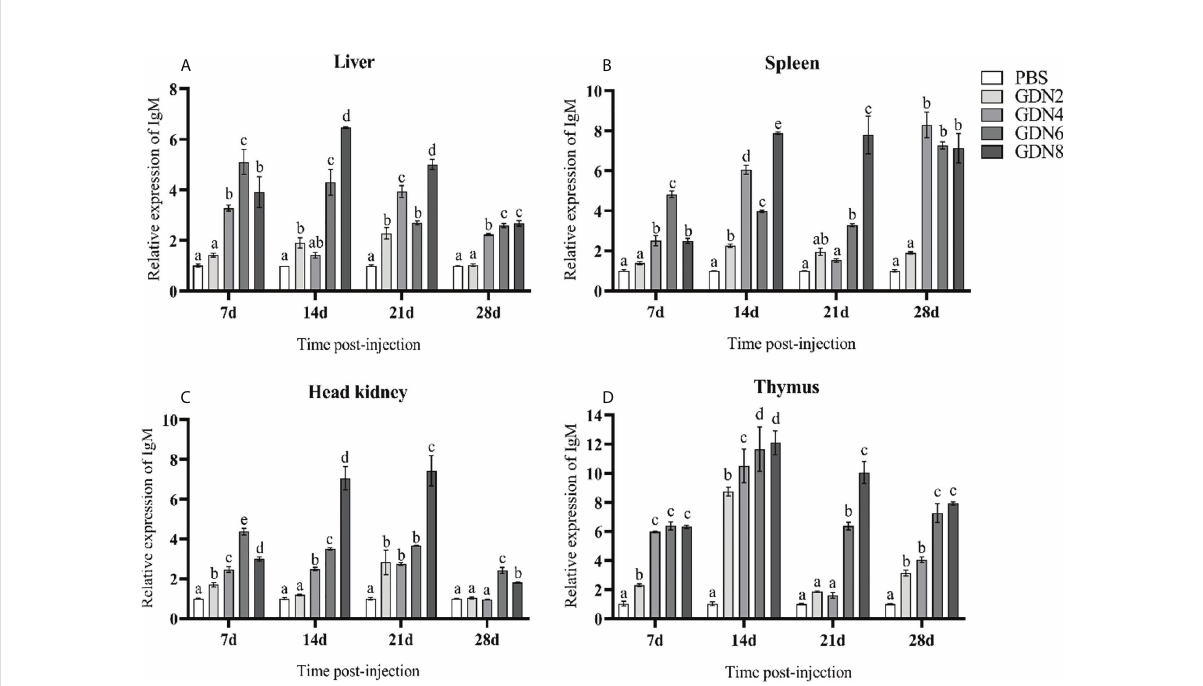
FIGURE 2 Expression levels of the IgM gene in the four tissues of pearl gentian grouper ( A , liver; B , spleen; C , head kidney; D , thymus) by qRT-PCR post- injection. The mRNA levels of the IgM gene were normalized to those of b -actin, and the relative expression levels were calculated. Signi fi cant differences ( p < 0.05) are marked by different letters (a –